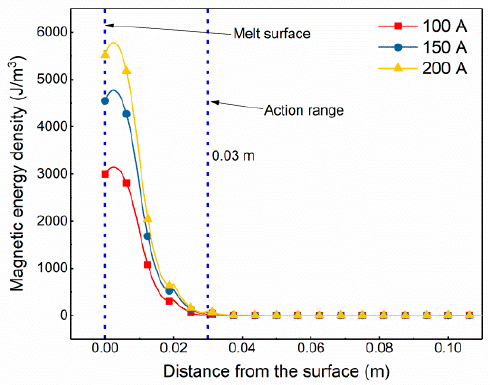
Figure 10. Magnetic energy density along the tracking path.